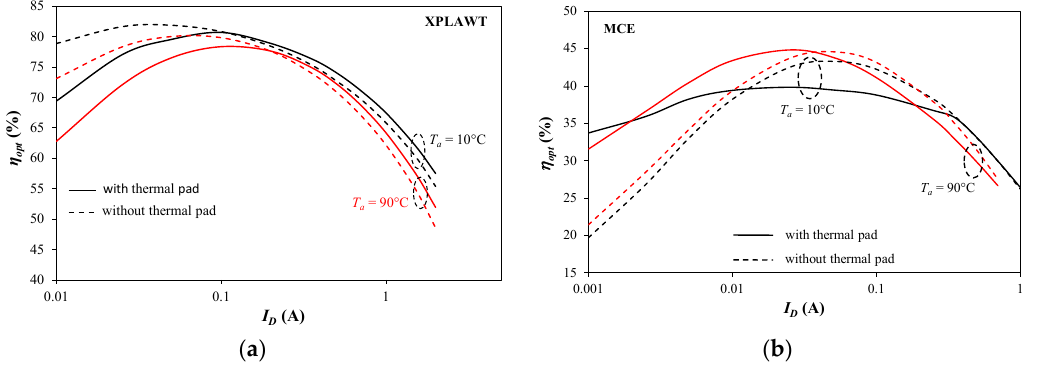
Figure 13. Measured dependences of radiant efficiency on the forward current for different cold plate temperature values for: ( a ) the XPLAWT; ( b ) MCE diodes.